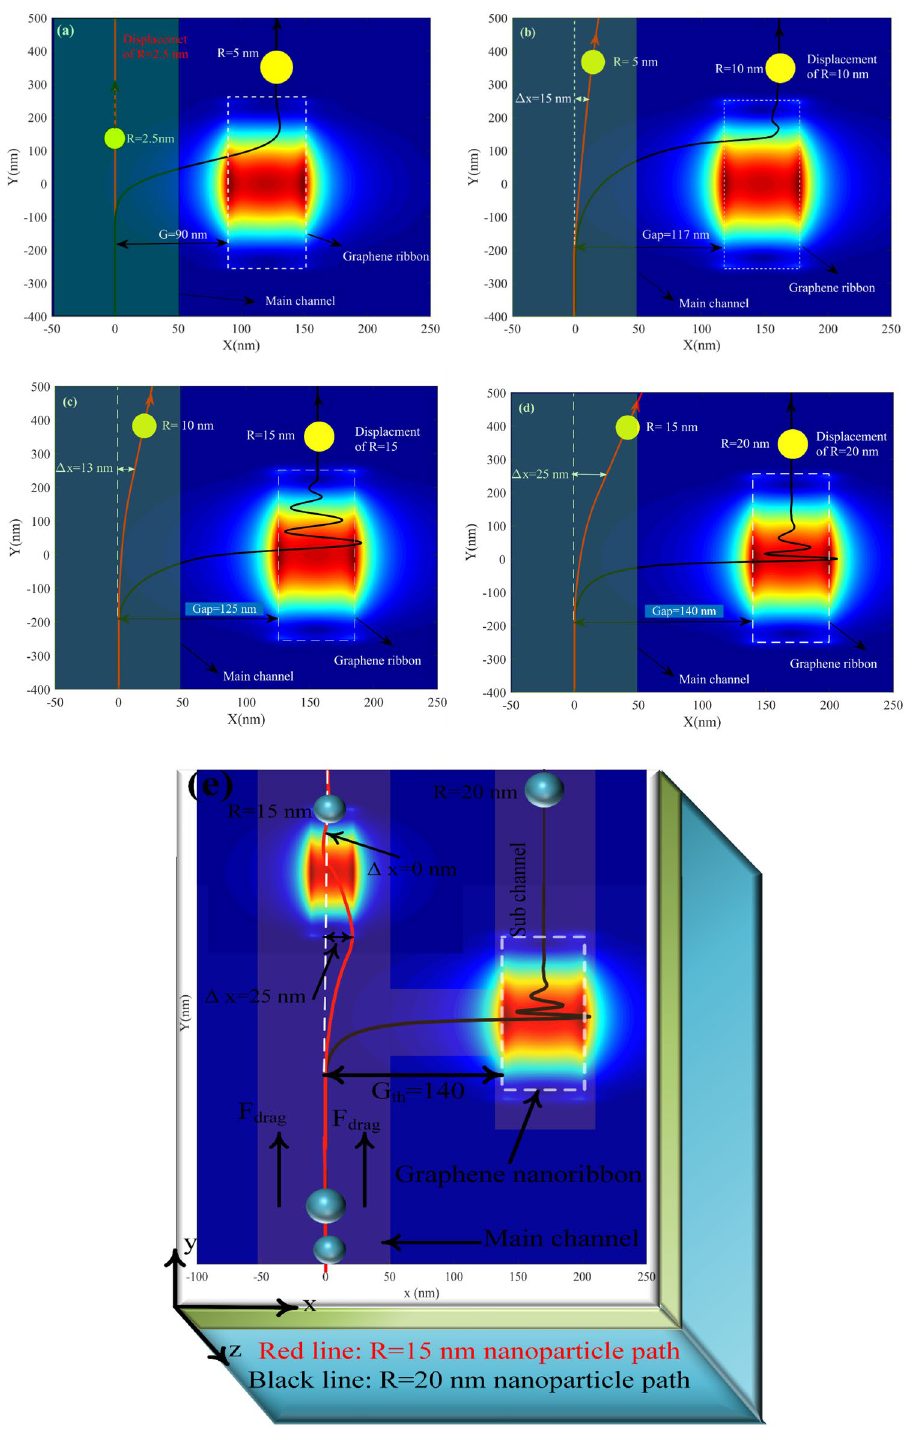
Figure 13. Displacement of nanoparticles with ( a ) R = 2.5 and 5 with G = 90 nm ( b ) R = 5 and 10 with G = 120 nm ( c ) R = 10 and 15 with G = 125 nm ( d ) R = 15 and 20 with G = 140 nm and ( e ) represents the dynamic response of R = 15 and 20 nm as same as ( d ) when the graphene nanoribbon located in the main channel is